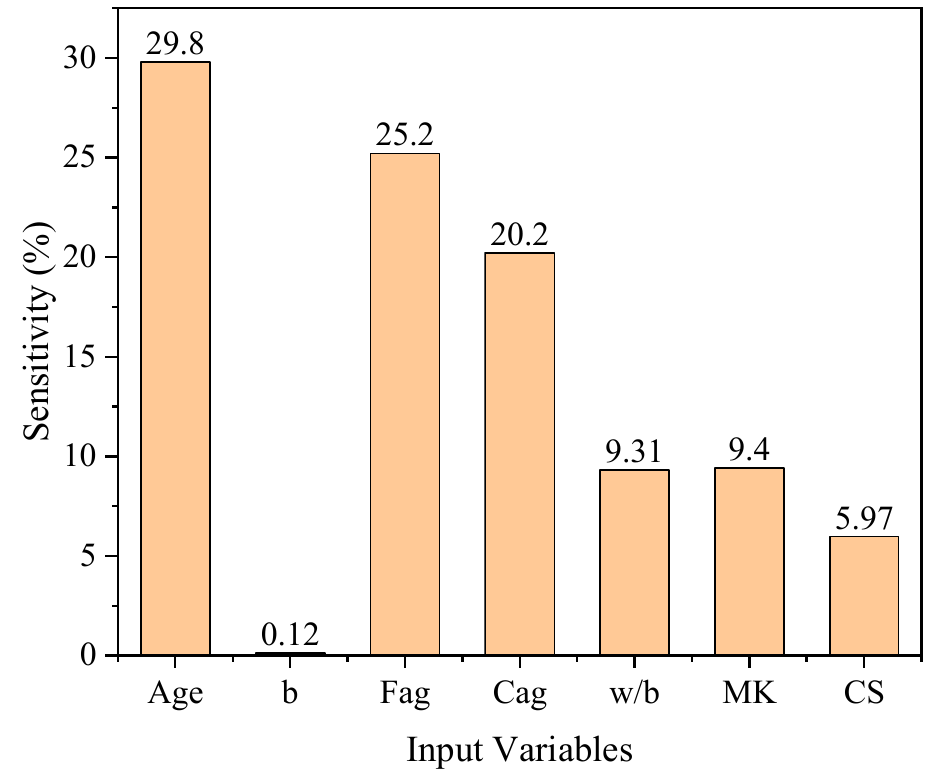
Figure 11. Sensitivity analysis of all input variables.